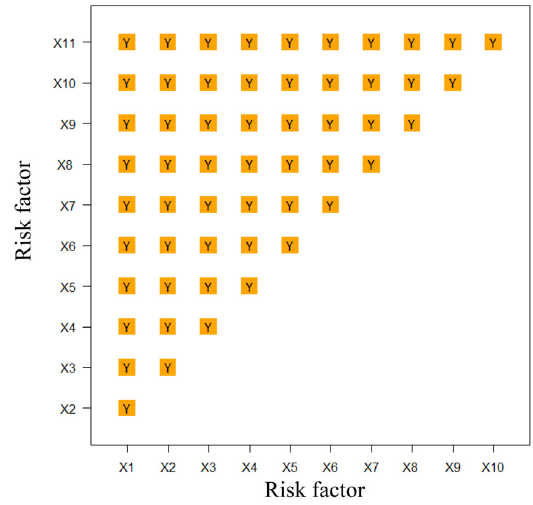
Figure 14. The result of ecological detection. Note: X1–X11 represents all environmental factors. Y represents the significant difference between the two environmental factors, while N indicates the insignificant difference (at the 95% confidence level).